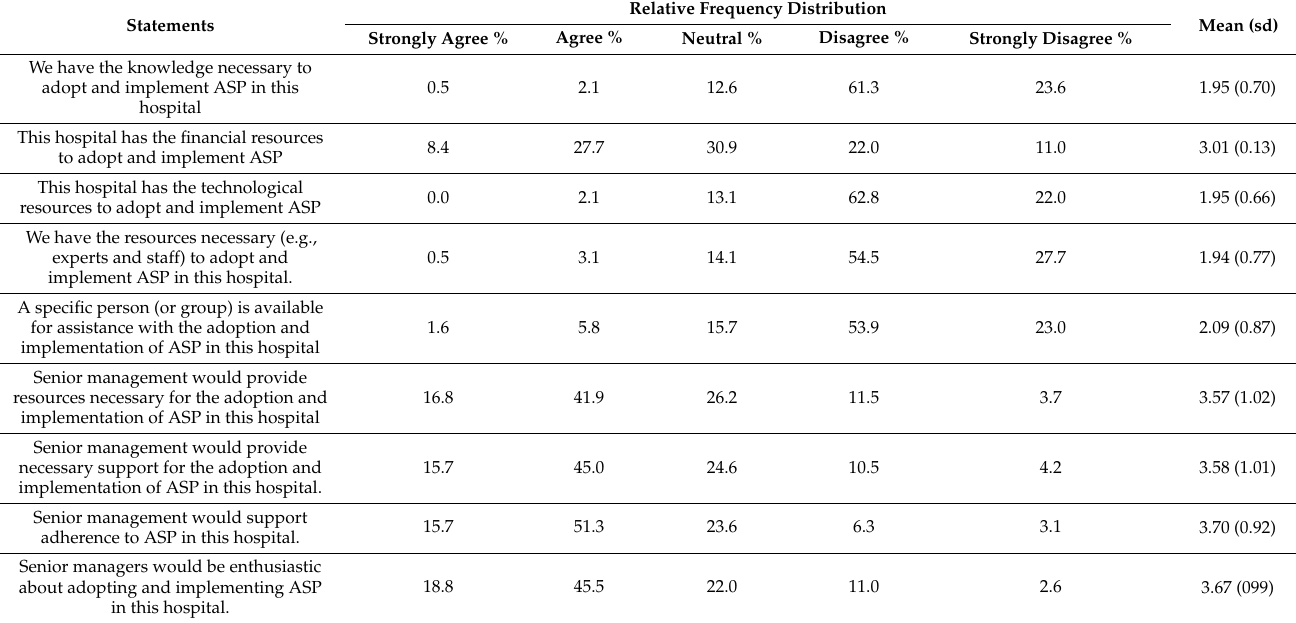
Table 7. MOH hospitals and their readiness to adopt ASPs.